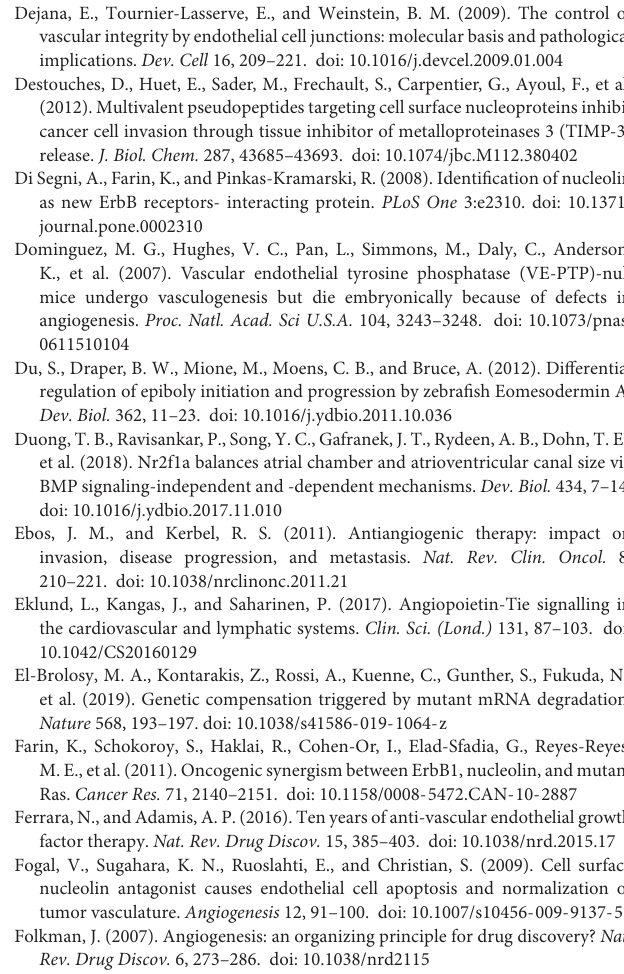
under microscope. The video showed the CV circulation in splice-blocking and ATG morpholino group, respectively, with comparison to control group. Supplementary Video 3 | Heart beat focused. Nxhl was silenced by using morpholino knockdown technique and the CV of zebrafish was observed under microscope. The video showed the heart beat in morpholino group with comparison to control